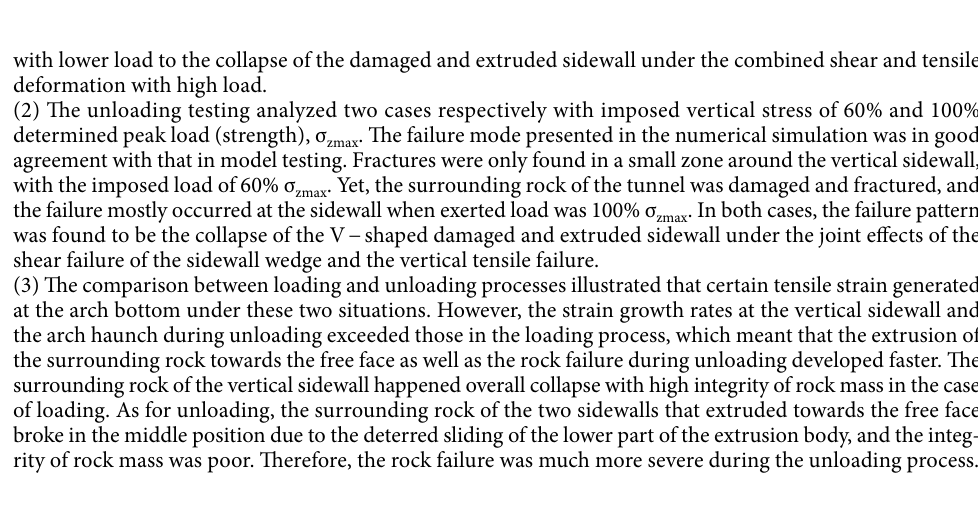
Figure 28. The stress variation of the measuring element at the arch crown and bottom during excavation